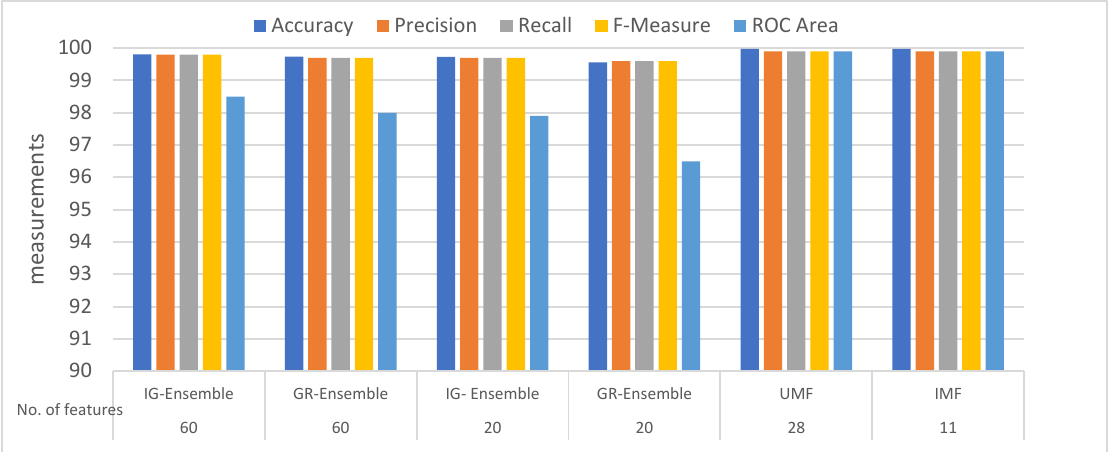
Figure 6. Graphical representation of performance metrics of IoTIDS20 using ensemble with various selected feature sets. Table 6. Performance metrics of IoTID20 using ensemble with various selected features. Feature